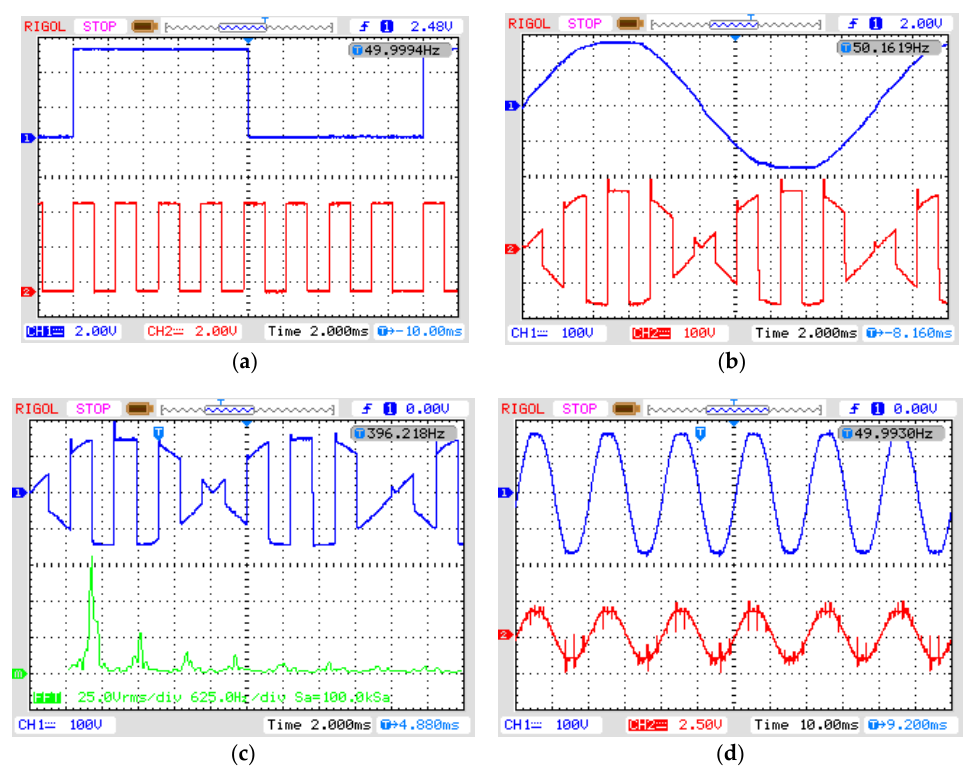
Figure 10. Outputs with zero-crossing detector (ZCD): ( a ) switching signals; ( b ) input-output voltage waveform; ( c ) fast Fourier transform (FFT) of the output voltage waveform; ( d ) input voltage-current